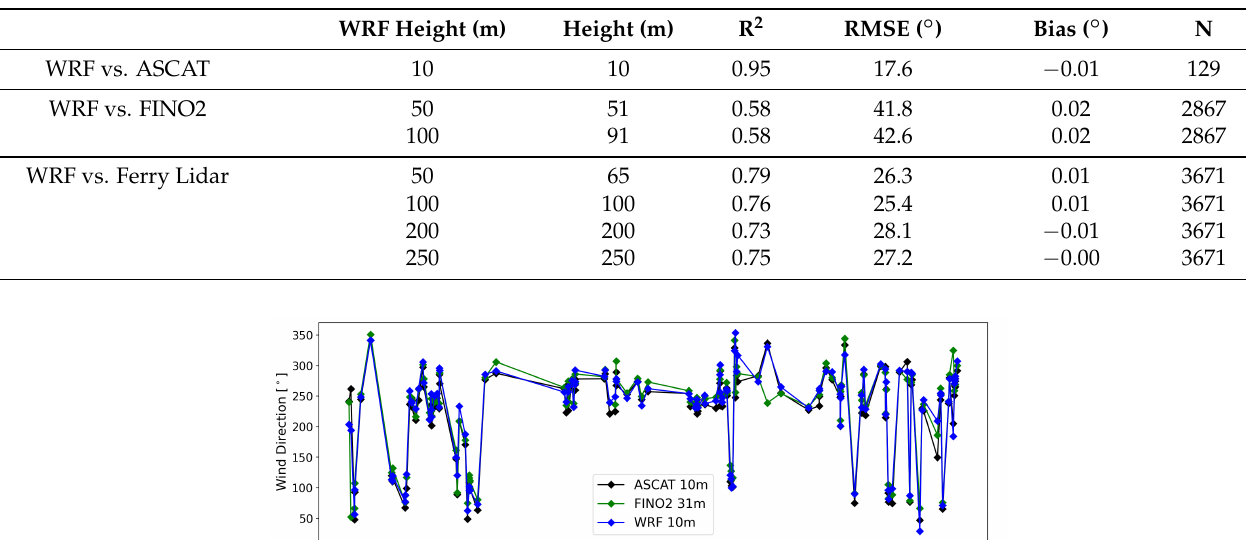
Table 6. RMSE results of the NEWA WRF data compared to the other data sources for the wind direction.